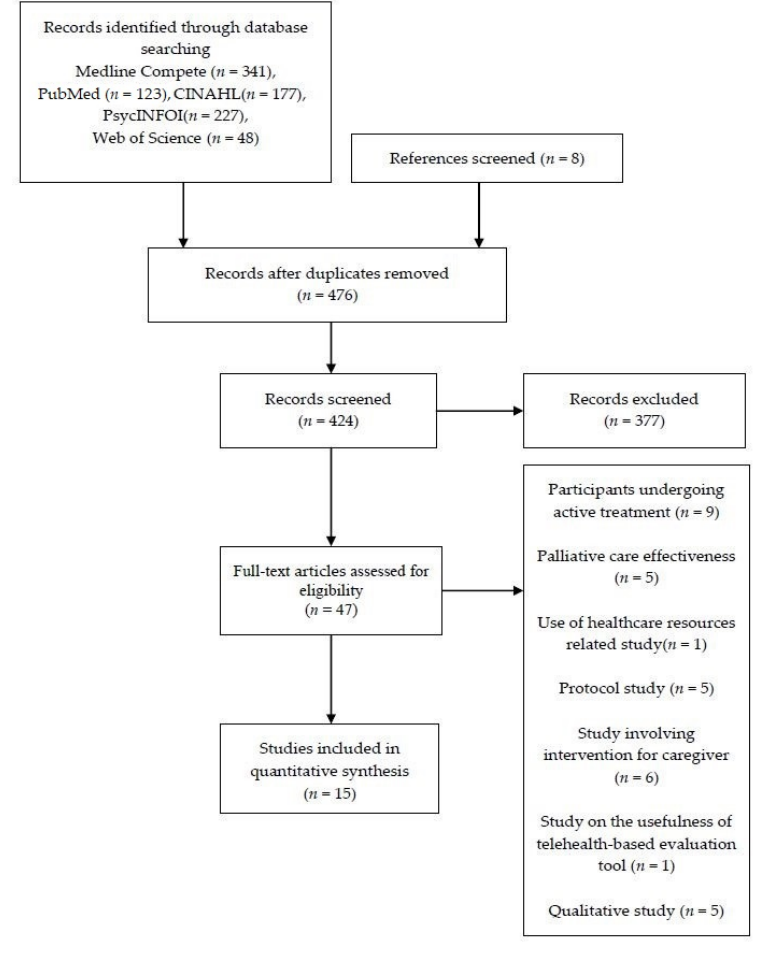
Figure 1. Study selection flow diagram and number of studies reviewed.